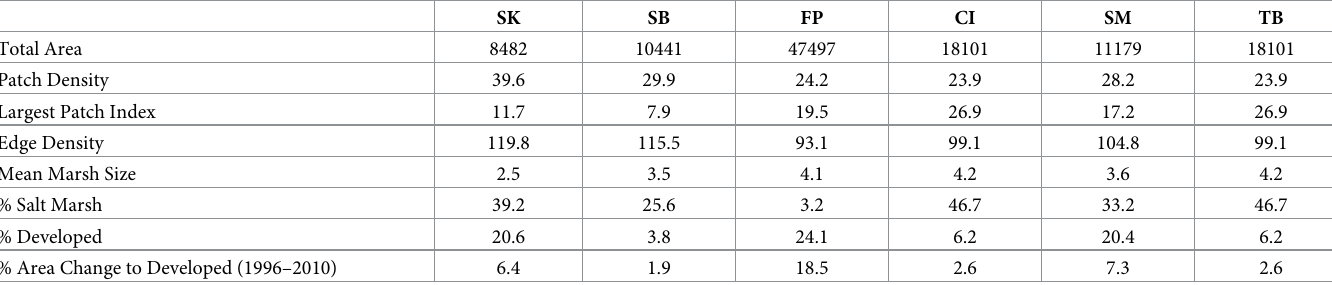
Table 1. Landscape characteristics of salt marsh